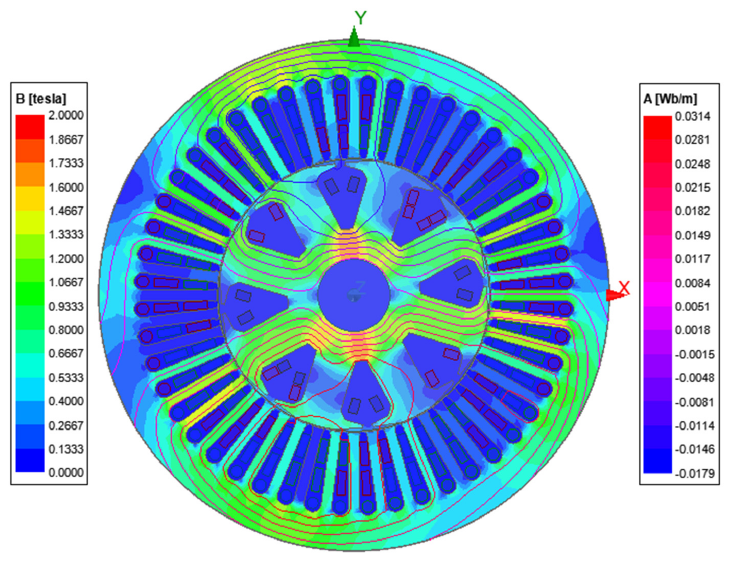
Figure 8. Stator flux density and flux line plot.